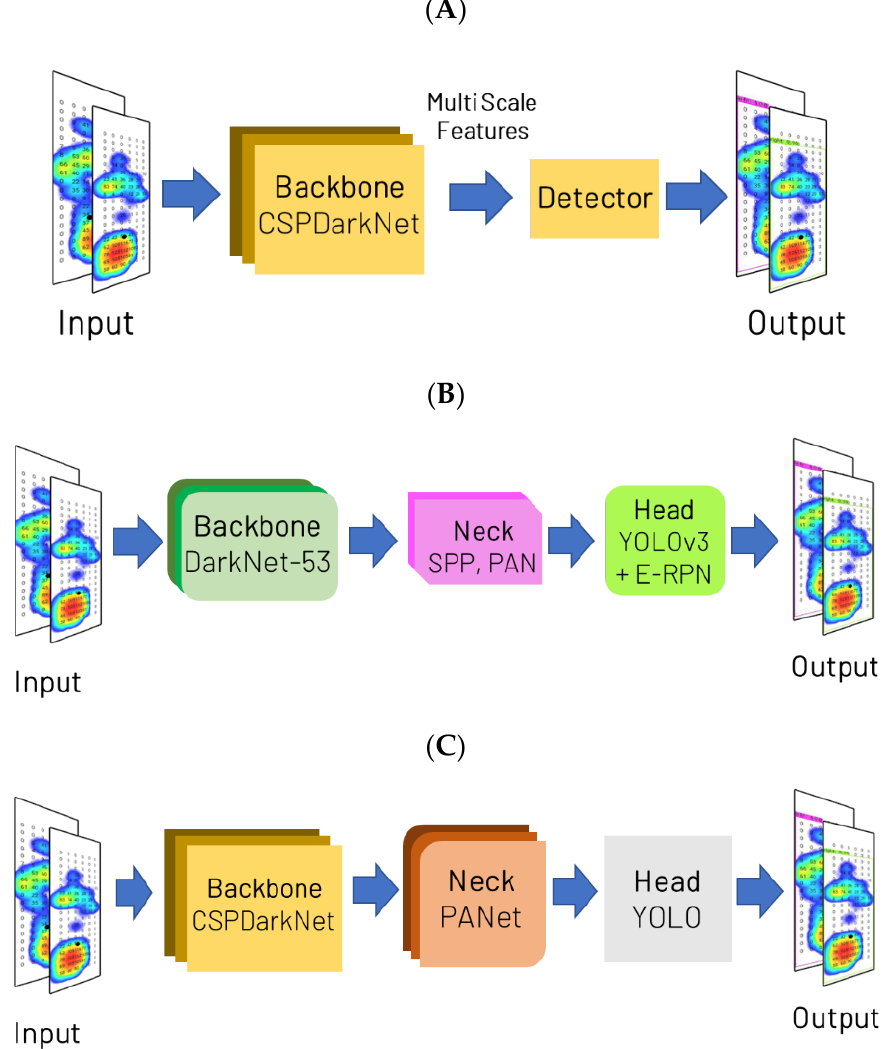
Figure 2. YOLO series Network Architecture; ( A ) YOLOv3 Network Architecture. ( B ) YOLOv4 Network Architecture. ( C ) YOLOv5 Network Architecture. Note: YOLO, You Only Look